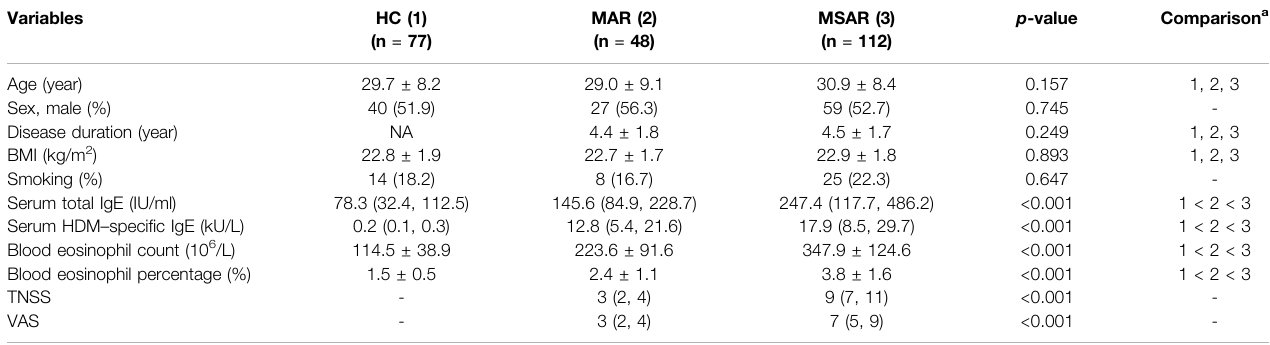
TABLE 1 | Demographic and clinical characteristics of participants among three groups. Variables